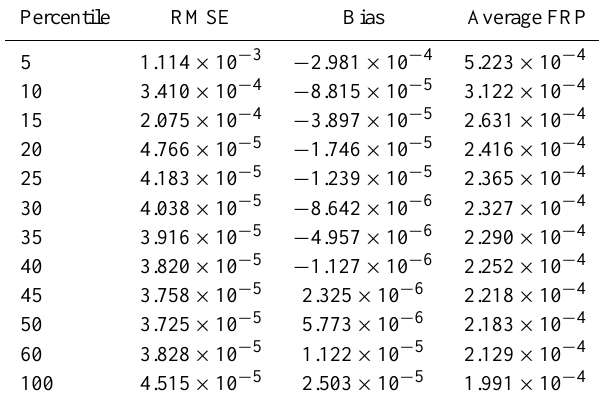
Table 3. RMSE and bias of mean global FRP in mWm − 2 for the year 2012 for Terra-GFAS as a function of the percentile of gridded FRP above which linear regression is applied instead of non-linear